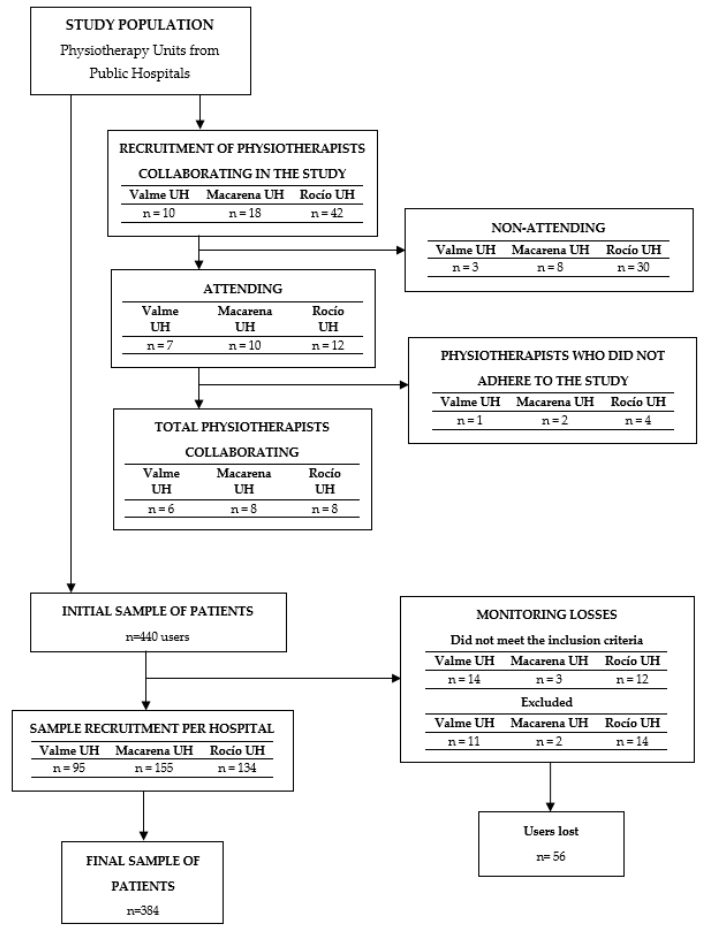
Figure 1. Flow chart of the selection process for the sample.